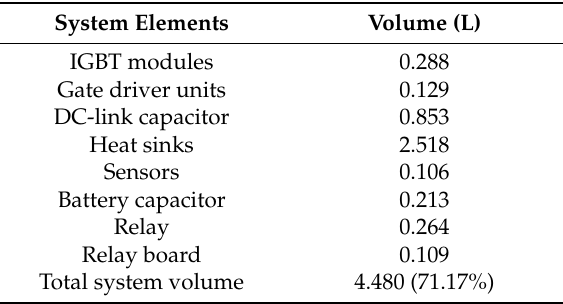
Table 2. Volume of the components in the proposed